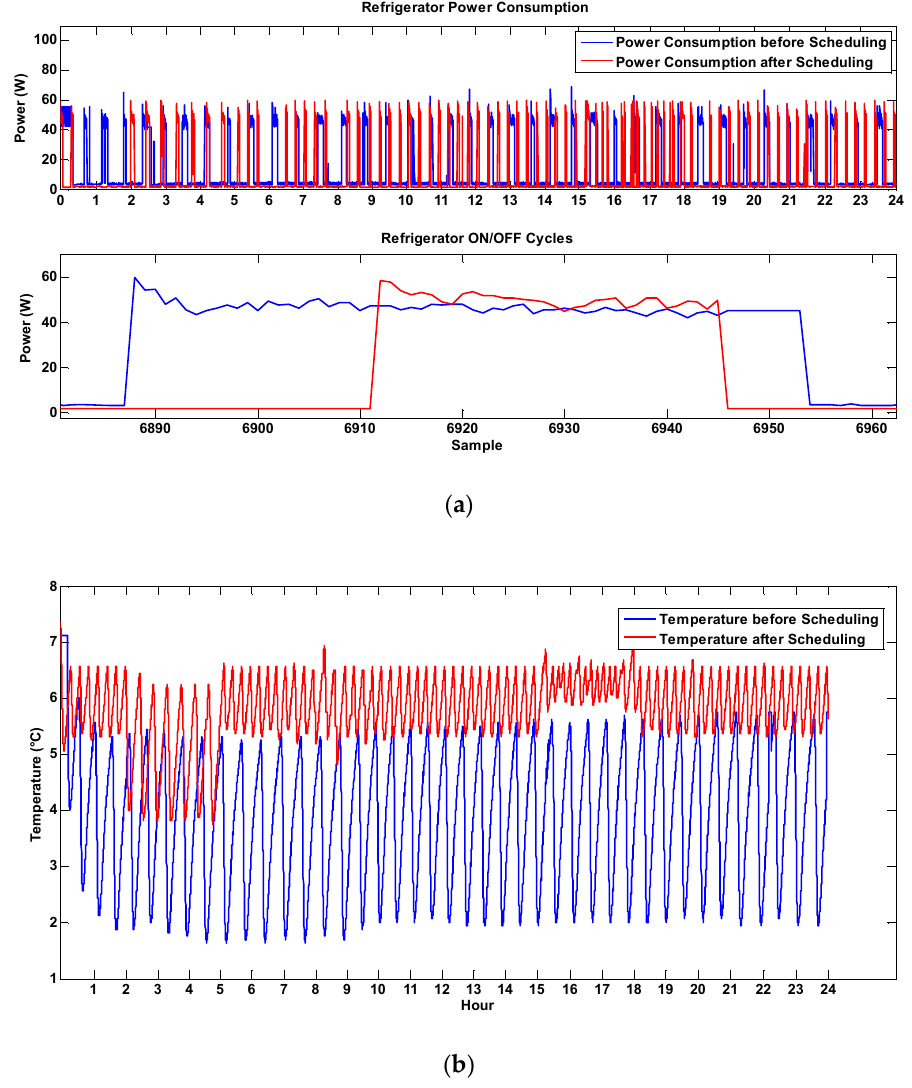
Figure 21. ( a ) Power consumptions and ( b ) internal temperatures of the refrigerator without and with the use of the HEM system.